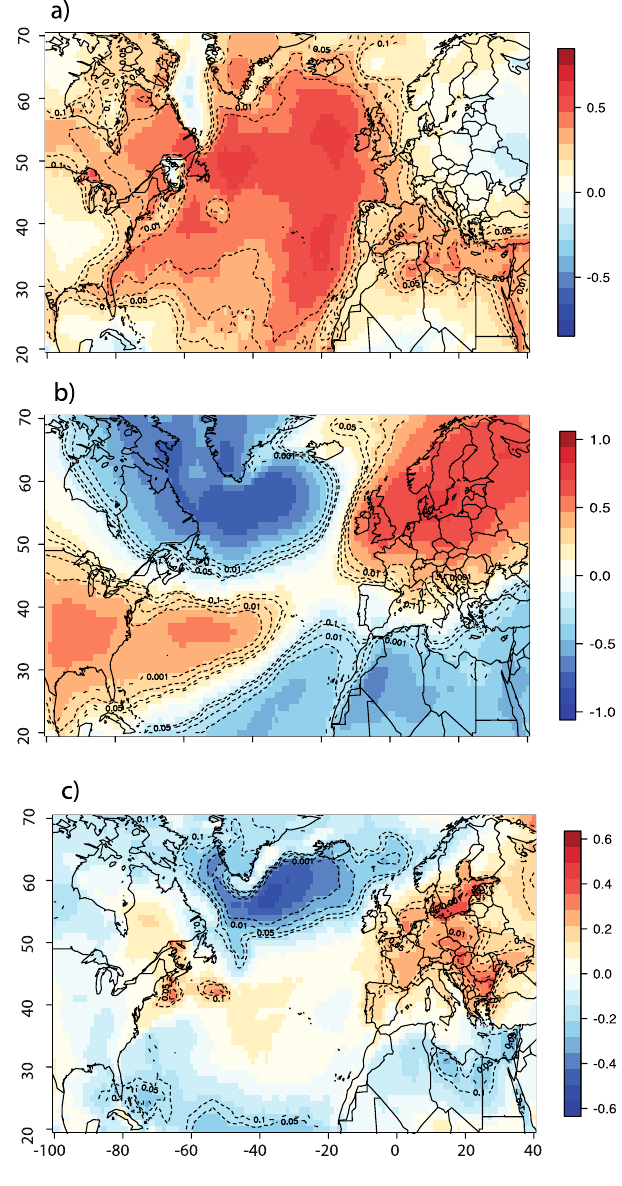
Figure 5. Analysis of ocean-atmosphere teleconnections across the North-Atlantic. Correlations between surface air temperatures and AMO during the growing season ( a ), between NAO and surface air temperatures during the winter season (DJF) ( b ), and between winter NAO (DJF) and surface air temperatures during the growing season ( c ). Dotted lines represent p values for these correlations, after taking into account serial autocorrelation. Map generated in R 63